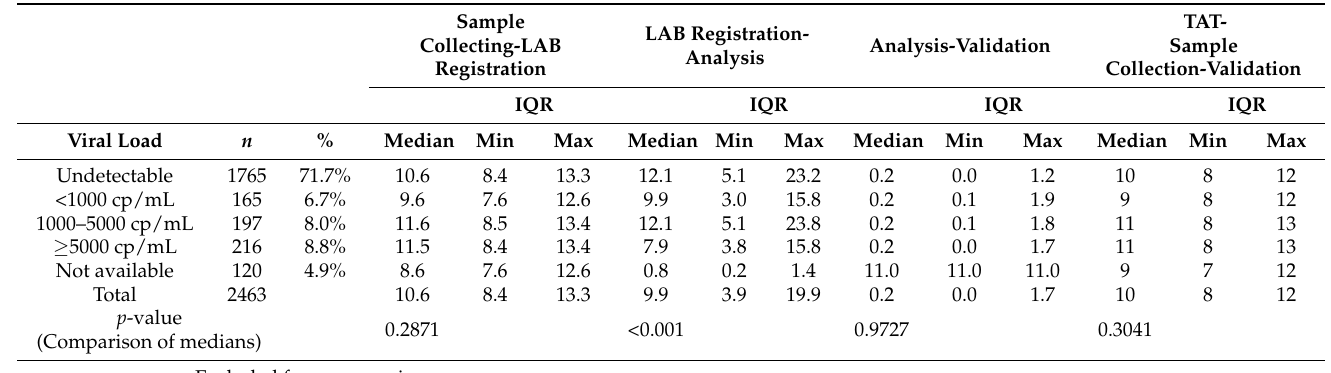
Table 1. Turn-Around Time in phases of the referencing chain according to the Viral Load.